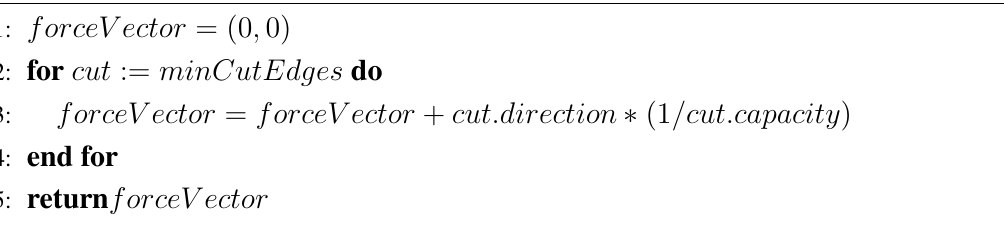
Algorithm 4 Min-Cut Force Algorithm